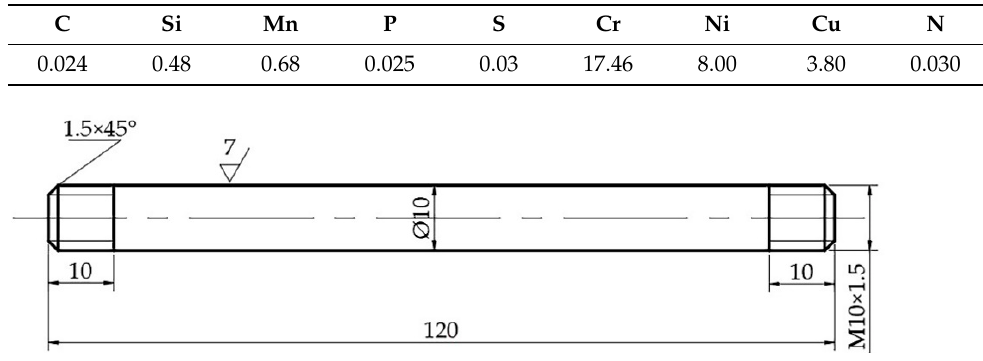
Figure 1. Sample processing drawing.